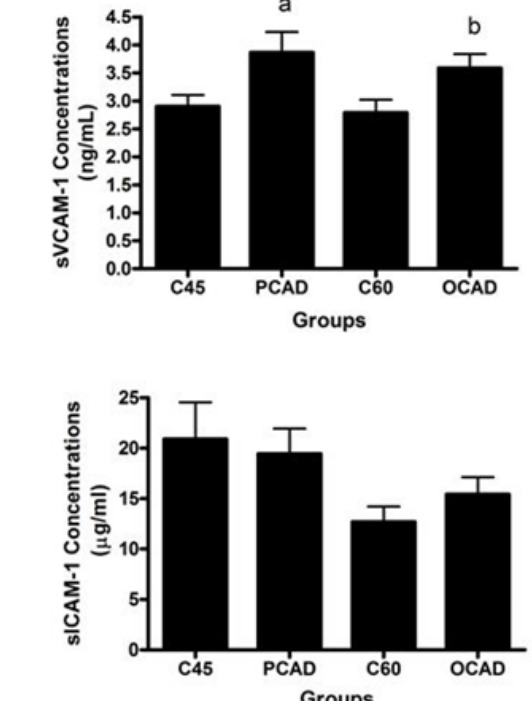
Figure 2. ( A ) The sVCAM-1 concentrations and ( B ) sICAM-1 in cases and control subjects. a p = 0.026 compared to C45 and b p = 0.023 compared to C60. The sVCAM-1 was analyzed using a t -test while sICAM-1 was analyzed using a Mann–Whitey test.